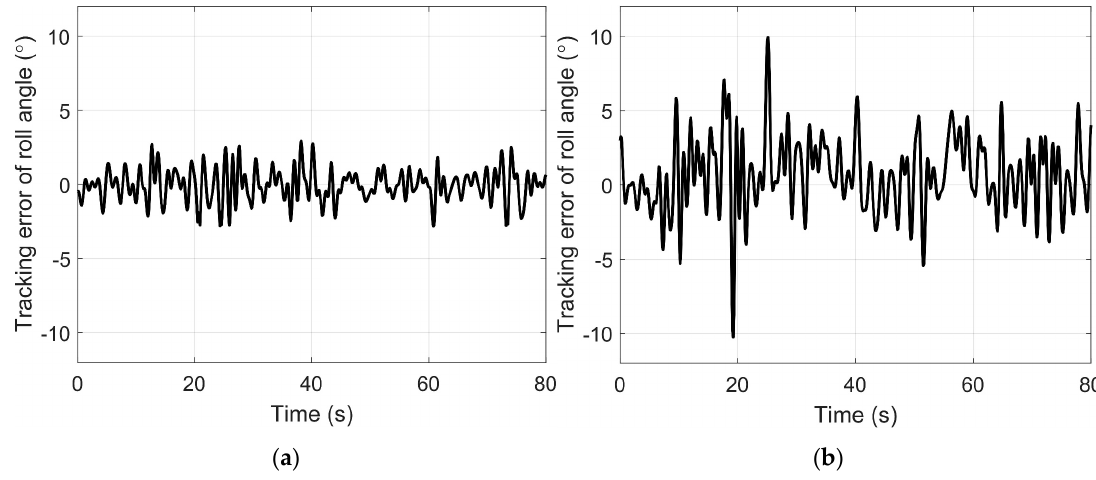
Figure 29. Tracking errors of roll angle using different control schemes: ( a ) FTADRC; ( b ) conventional ADRC. Electronics 2018 , 7 , x FOR PEER REVIEW 27 of 31